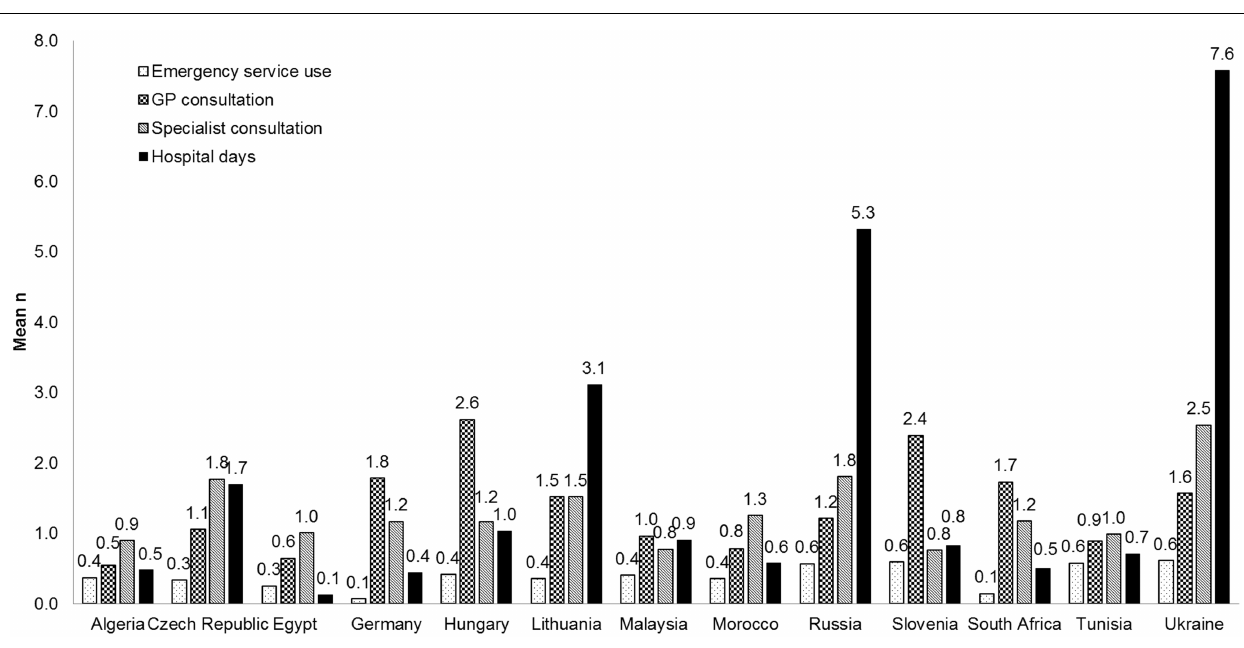
FIGURE 3 | Healthcare utilization by patients with vertigo during the 3months beforeVisit 1 by country